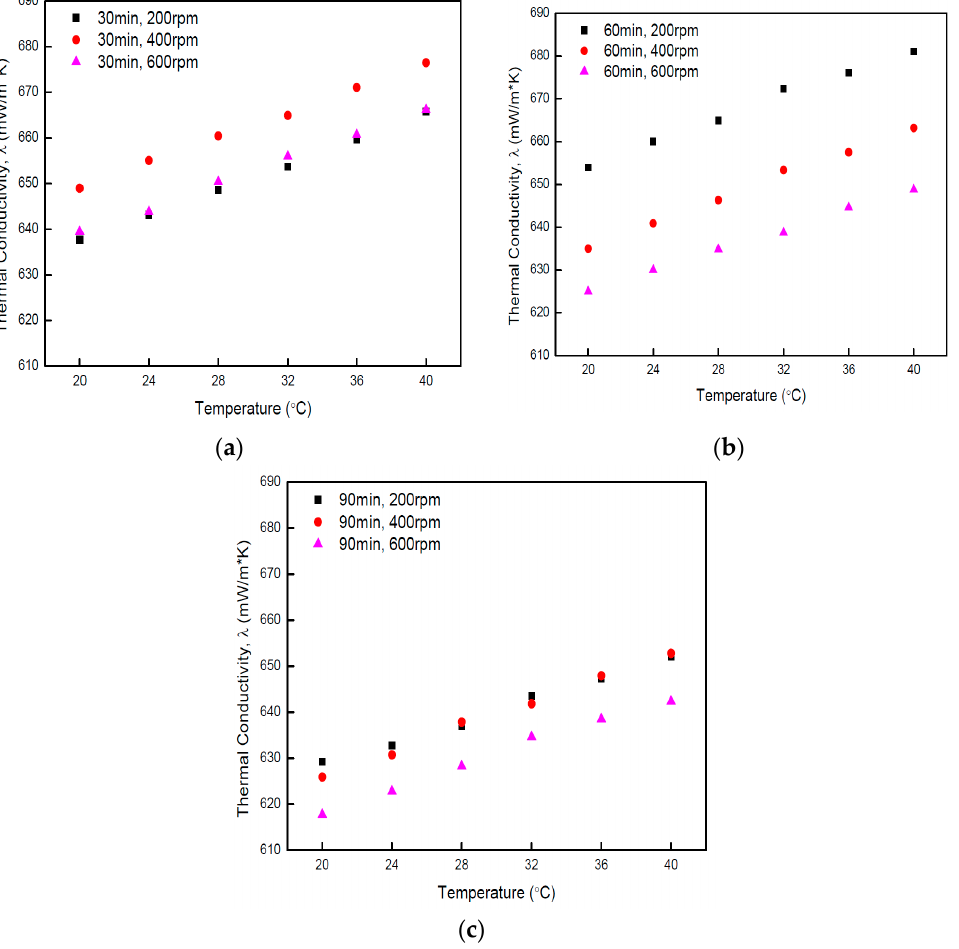
Figure 6. The thermal conductivity measurement value of the changes in the grinding time. ( a ) Grinding time: 30 min; ( b ) Grinding time: 60 min; ( c ) Grinding time: 90 min. time: 30 min; ( b ) Grinding time: 60 min; ( c ) Grinding time: 90